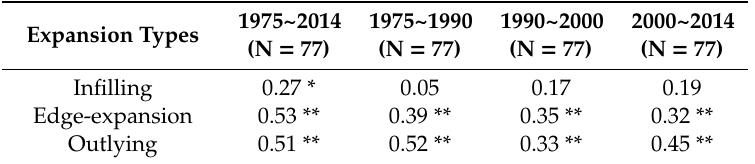
Table 5. Pearson correlation coe ffi cients between the expansion types of built-up land in floodplains and flood occurrence in the North China Plain Area